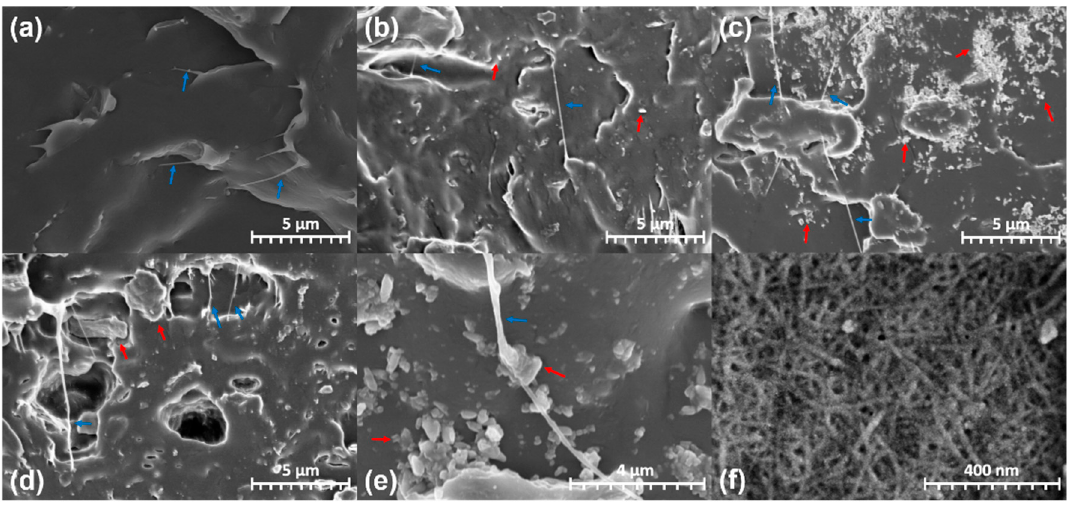
Figure 4. SEM micrographs of CNF and fractured surface images of PP/CNF and PP/CNF/nanoclay nanocomposites including CNF (blue arrow) and nanoclay (red arrow): ( a ) PCN0, ( b ) PCN1, ( c ) PCN3, ( d ) PCN5, ( e ) nanoclays attached to the CNF surface in the PP matrix (PCN3), and ( f ) CNF.